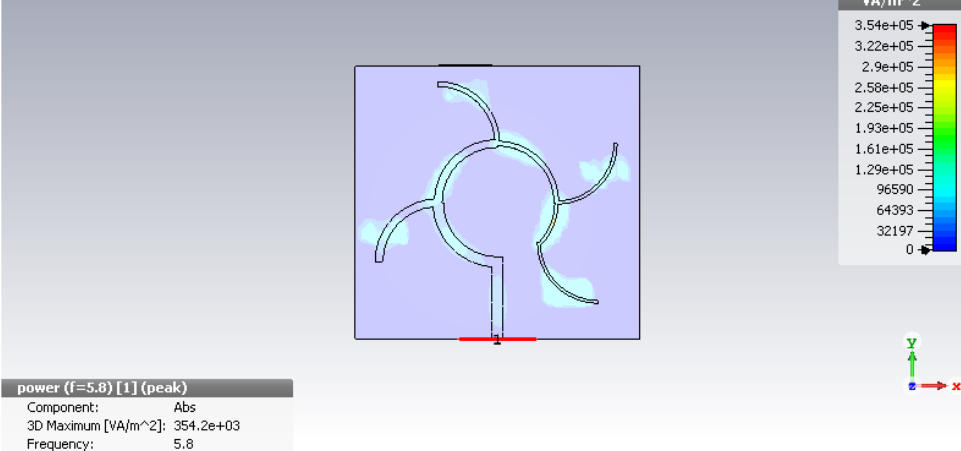
Figure 6. Power distribution in the feeding array